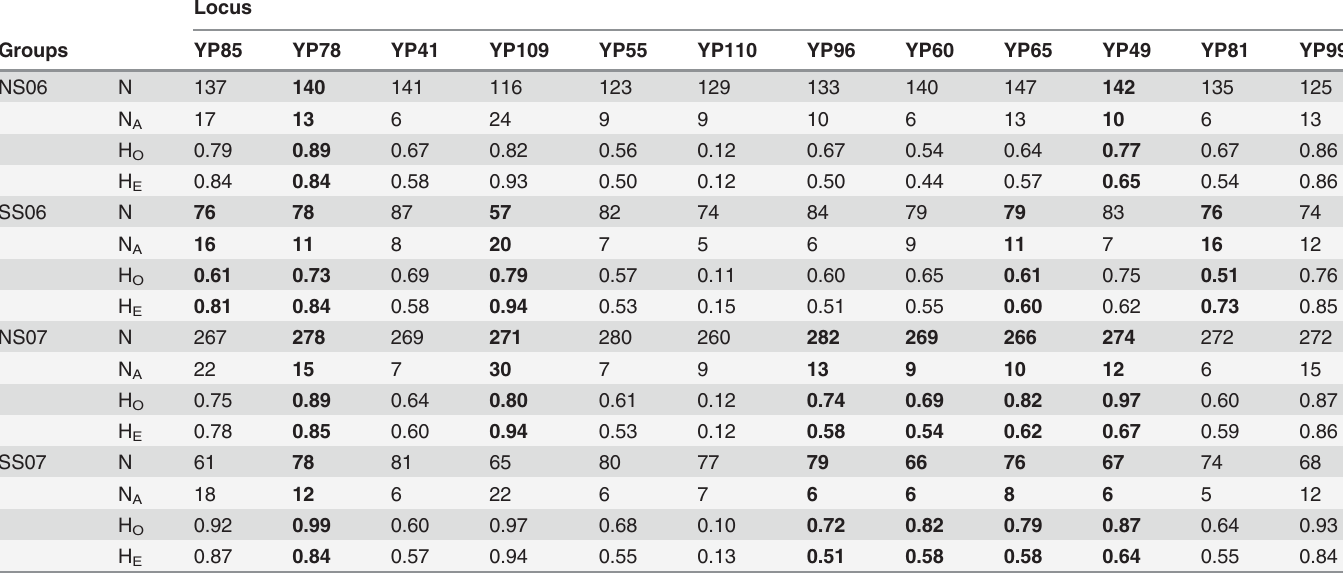
Table 1. Number of genotypes (N), alleles (N A ), and observed (H O ) and expected (H E ) heterozygosity for the 12 microsatellite loci (Li et al. 2007) used to genotype larval yellow perch (YP) collected in north-shore (NS) and south-shore (SS) waters of Lake Erie ’ s western basin during 2006 (N NS larvae = 151, N SS larvae = 91) and 2007 (N NS larvae = 283, N NS larvae =